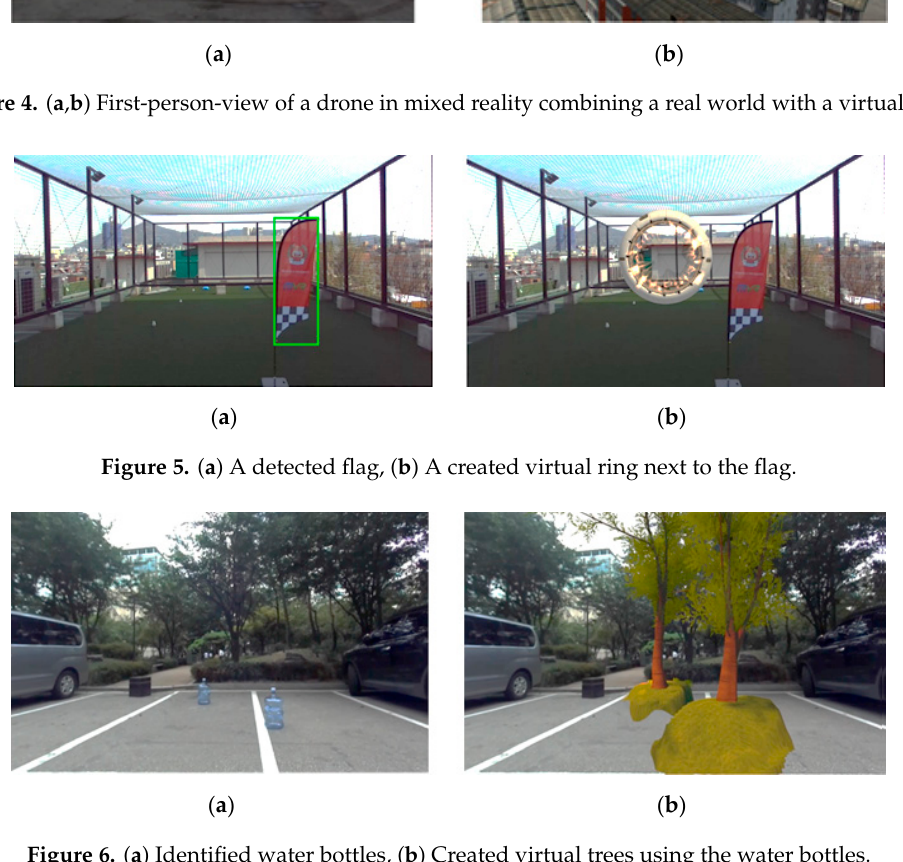
Figure 6. ( a ) Identified water bottles, ( b ) Created virtual trees using the water bottles.